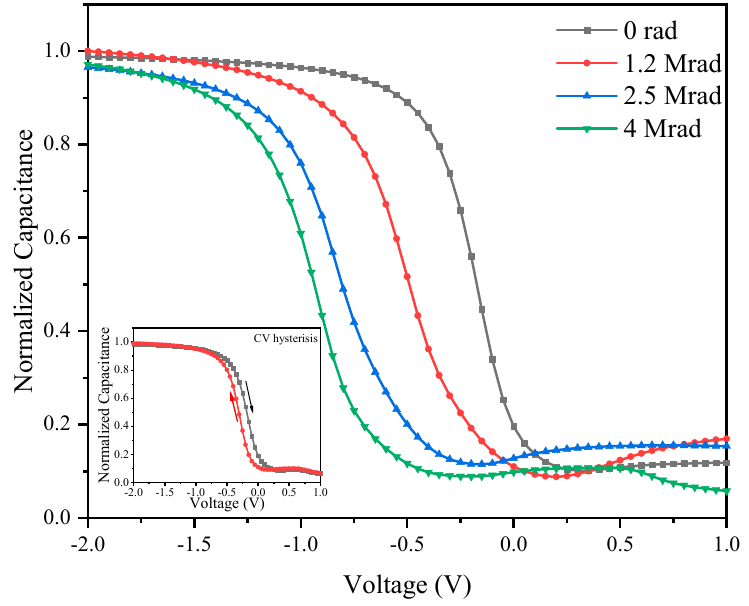
Figure 6. CV characteristic of the 14.1 nm Al 2 O 3 based MOS structures before and after irradiation. The CV curves of the MOS structures shift to the negative voltage direction after radiation and the voltage shift increases with the increase of the radiation total dose, indicating that positive oxide trapped charge were generated inside Al 2 O 3 gate dielectric during gamma-ray irradiation. On the other hand, the post-radiation CV curves show stretch-out which demonstrates the generation of interface trapped charge in the MOS structure. The radiation induced oxide and interface trapped charge densities can be figured out by using Terman method and the results are shown in Figure 7, and the results are average value of more than eight samples which have very low CV